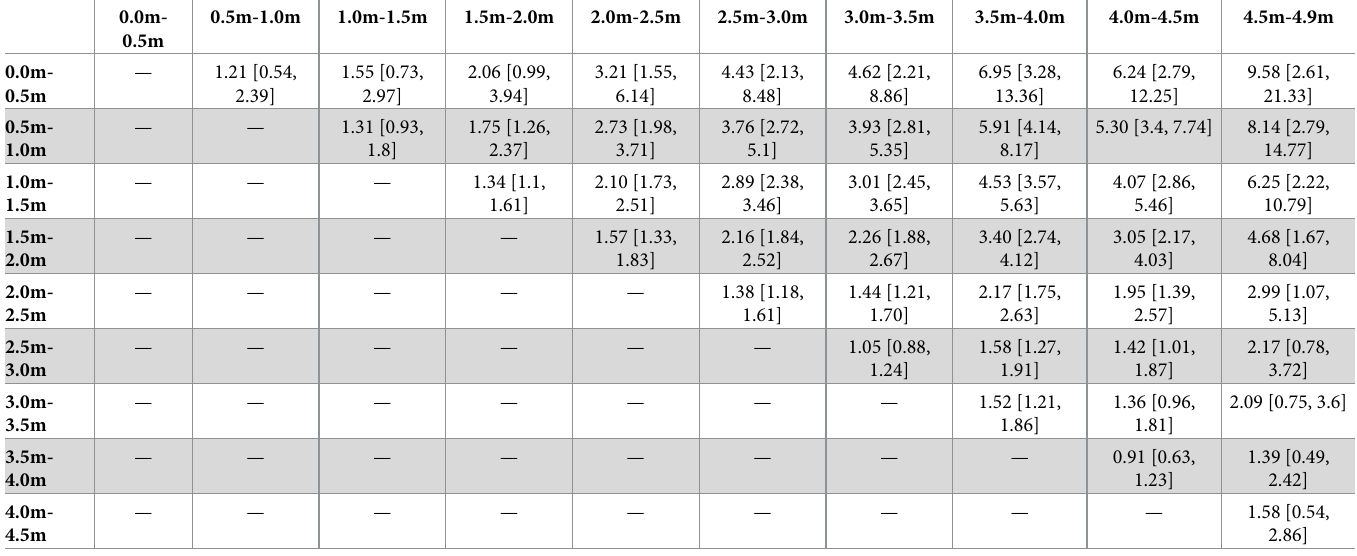
Table 2. Relative odds [ ± 95% confidence intervals] of missing shots as distance increases. Each column compares the relative odds of missing compared to the current row. 0.0m-